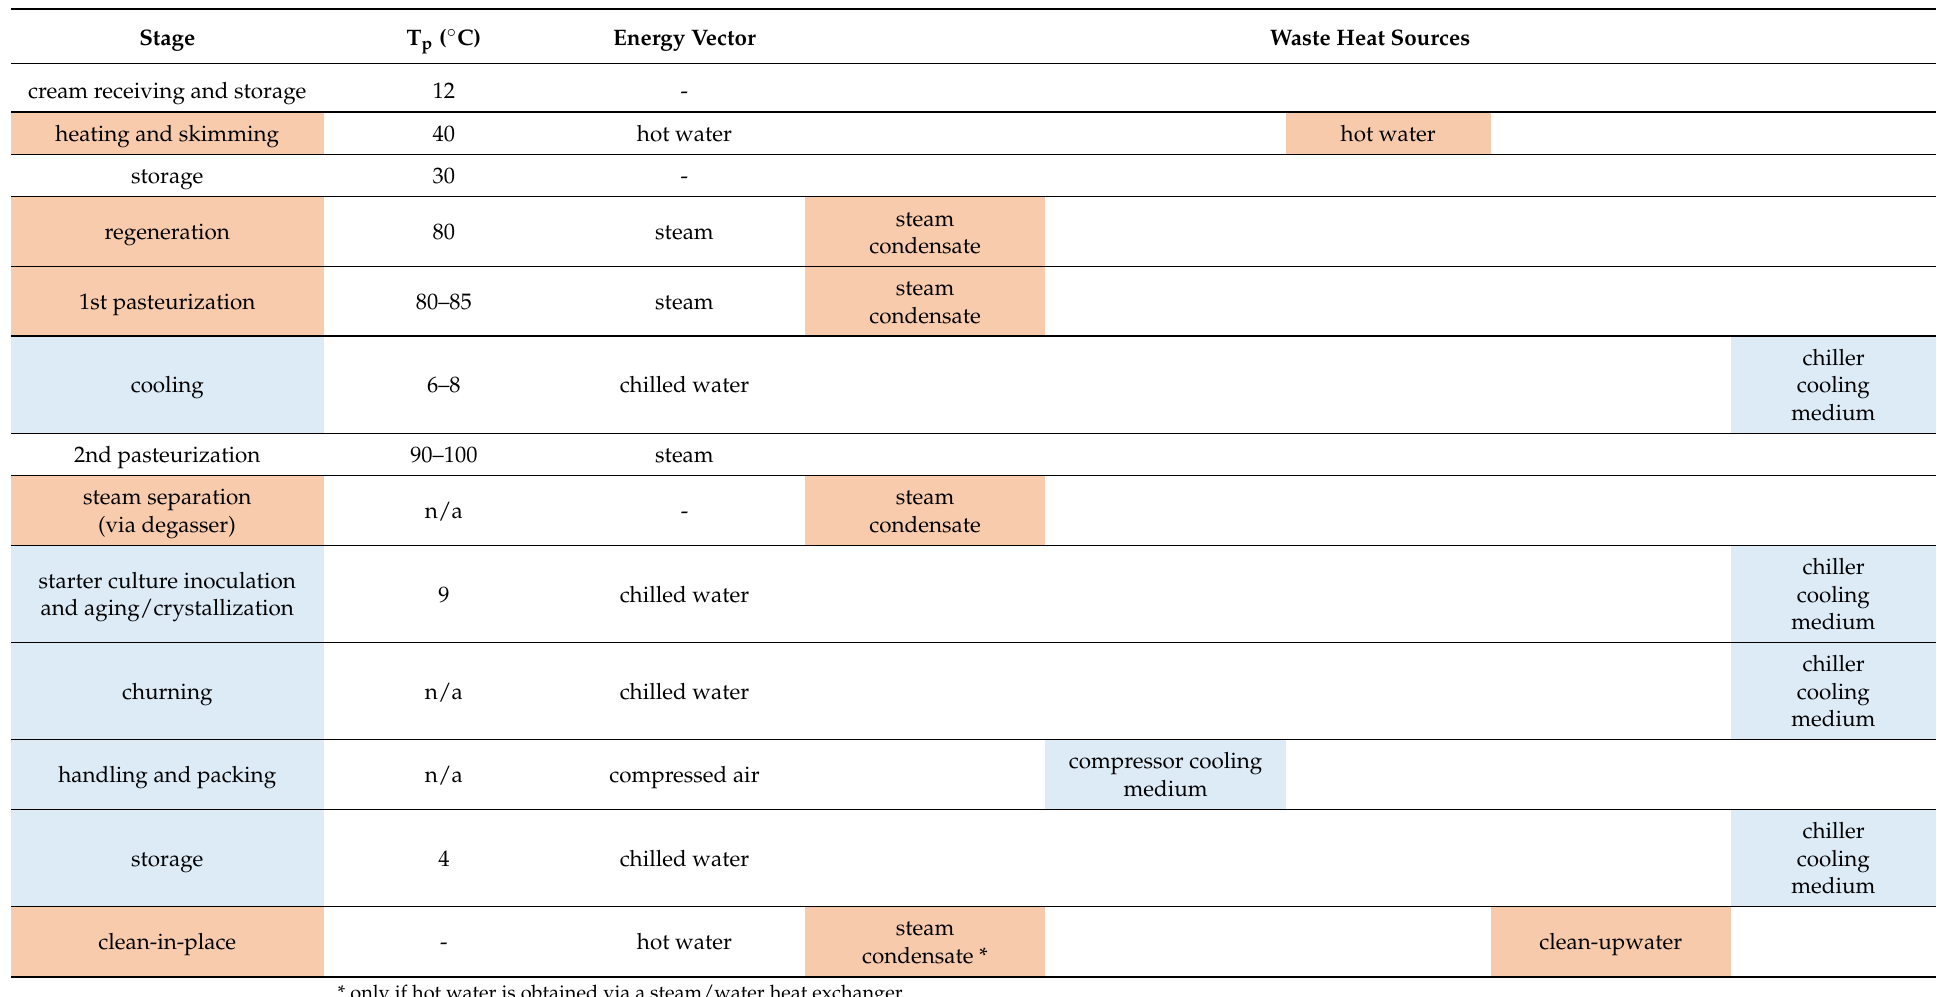
Table A5. Scheme of butter manufacturing process and corresponding low-temperature waste heat